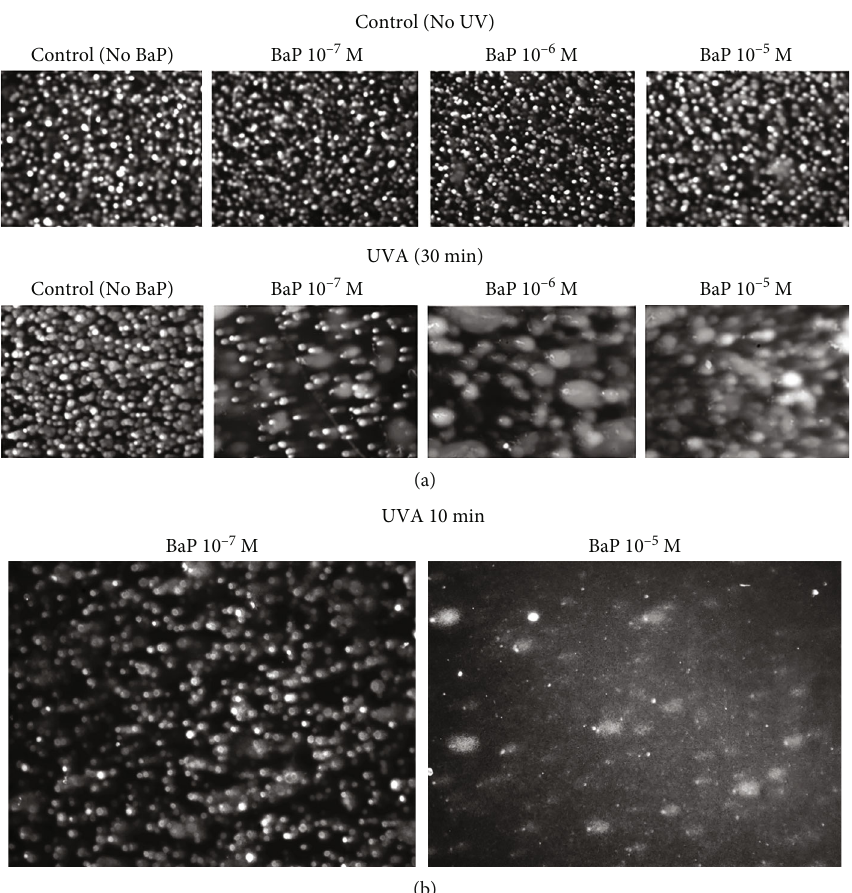
Figure 1: Comet assay sample images under various UVA and BaP treatment conditions. BaP concentration (10 − 7 to 10 − 5 ) mol/L. UVA exposure times were at an intensity of 3.5mW/cm 2 . (a) 30min dose = 6 : 3 J/cm 2 . (b) 10 min dose = 2 : 1J/cm 2 . M: mol/L (see Materials and Methods).